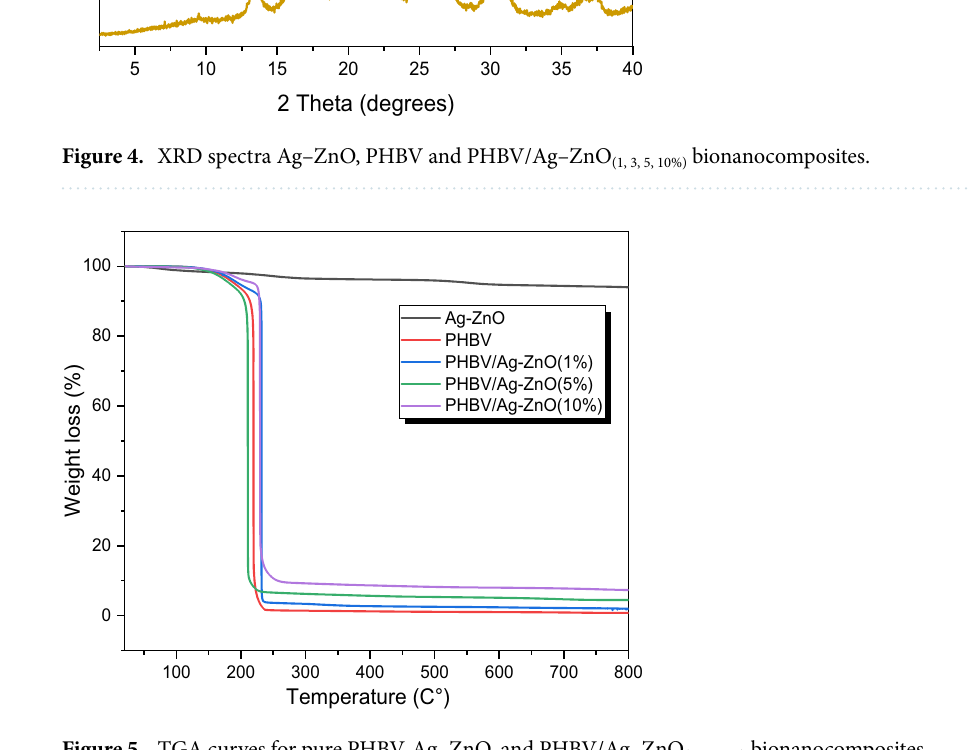
Figure 5. TGA curves for pure PHBV, Ag–ZnO, and PHBV/Ag–ZnO (1, 5, 10%)